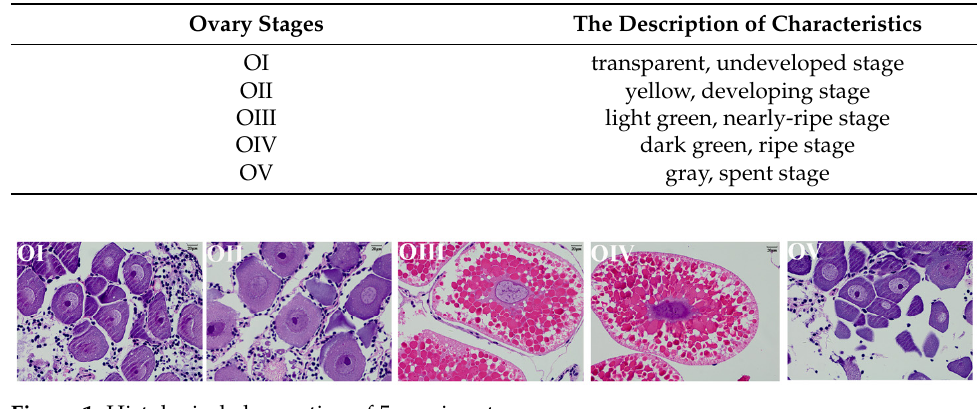
Figure 1. Histological observation of 5 ovarian stages.